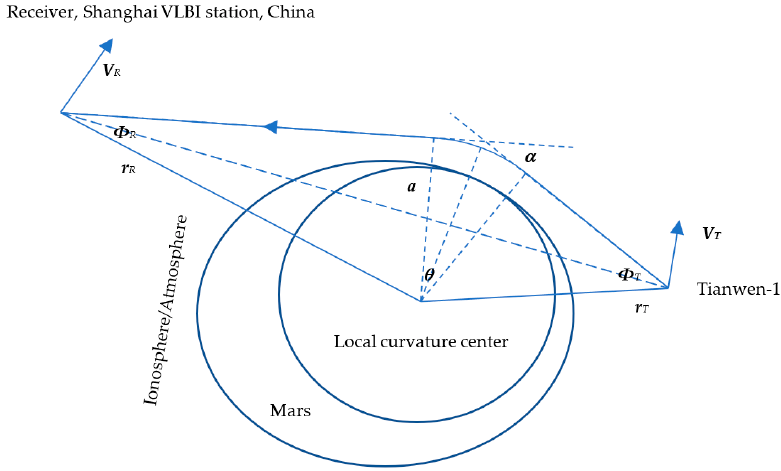
Figure 1. Geometric relationship of Tianwen-1 radio